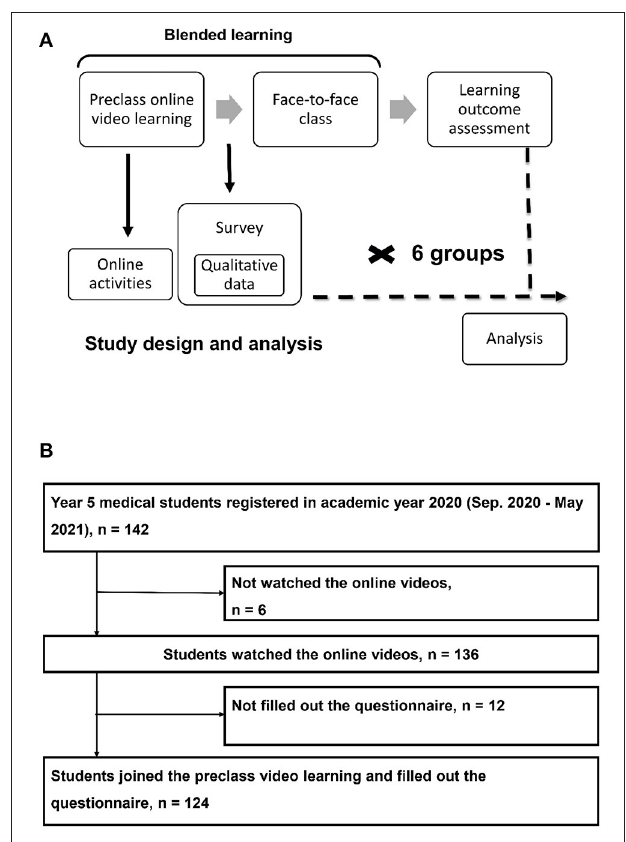
FIGURE 1 | Study design (A) and participants (B)